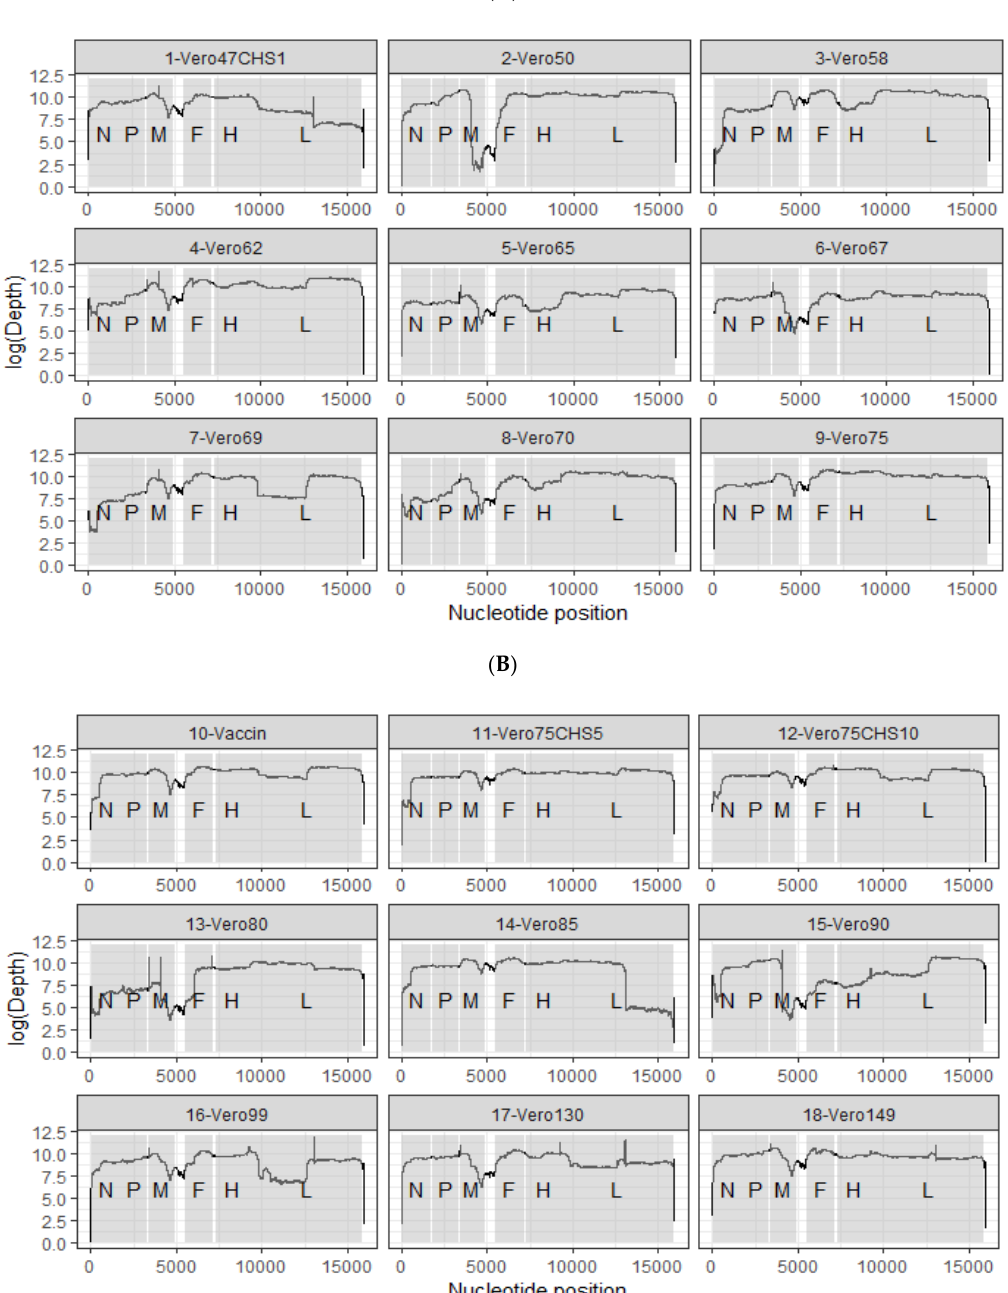
Figure 1. Summary of the different viral strains made available during this study. Coverage and depth of all the sequenced passages are shown in both ( A ) and ( B ). CHS: CV1 cell line stably expressing the goat SLAM.